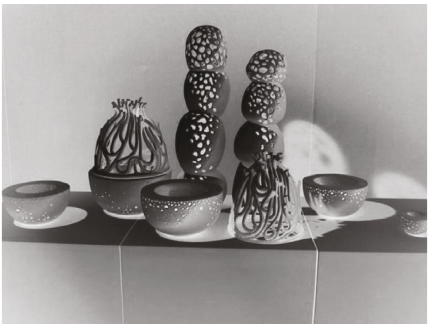
Figure 8: Example of three-dimensional structure design. Table 1: Evaluation of the effect of appearance design of ceramic art based on VR visualization